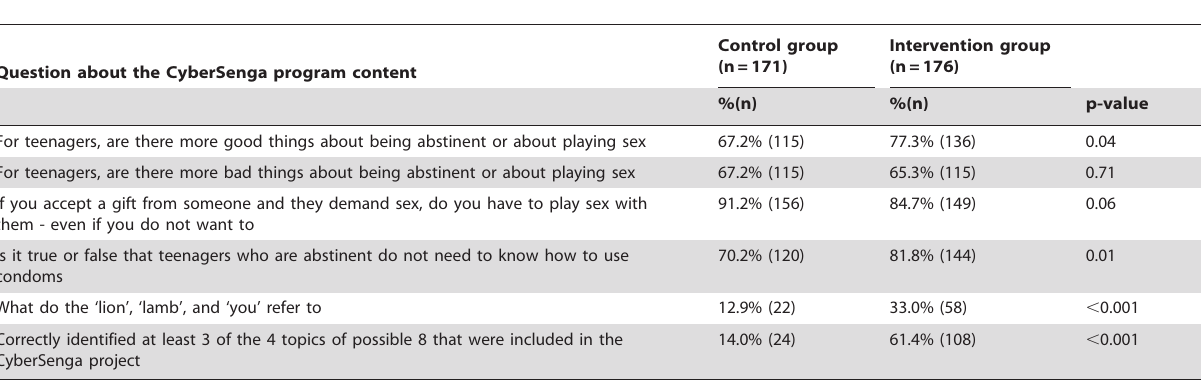
Table 6. Indications of contamination: A comparison of the frequency of correct answers in the intervention and control groups to questions about the CyberSenga program content at three-month follow-up